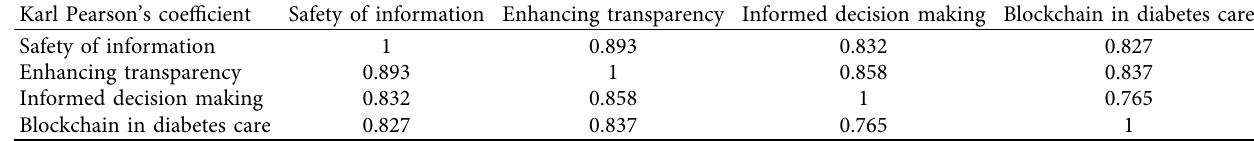
Table 3: Karl Pearson’s coefficient of correlation.